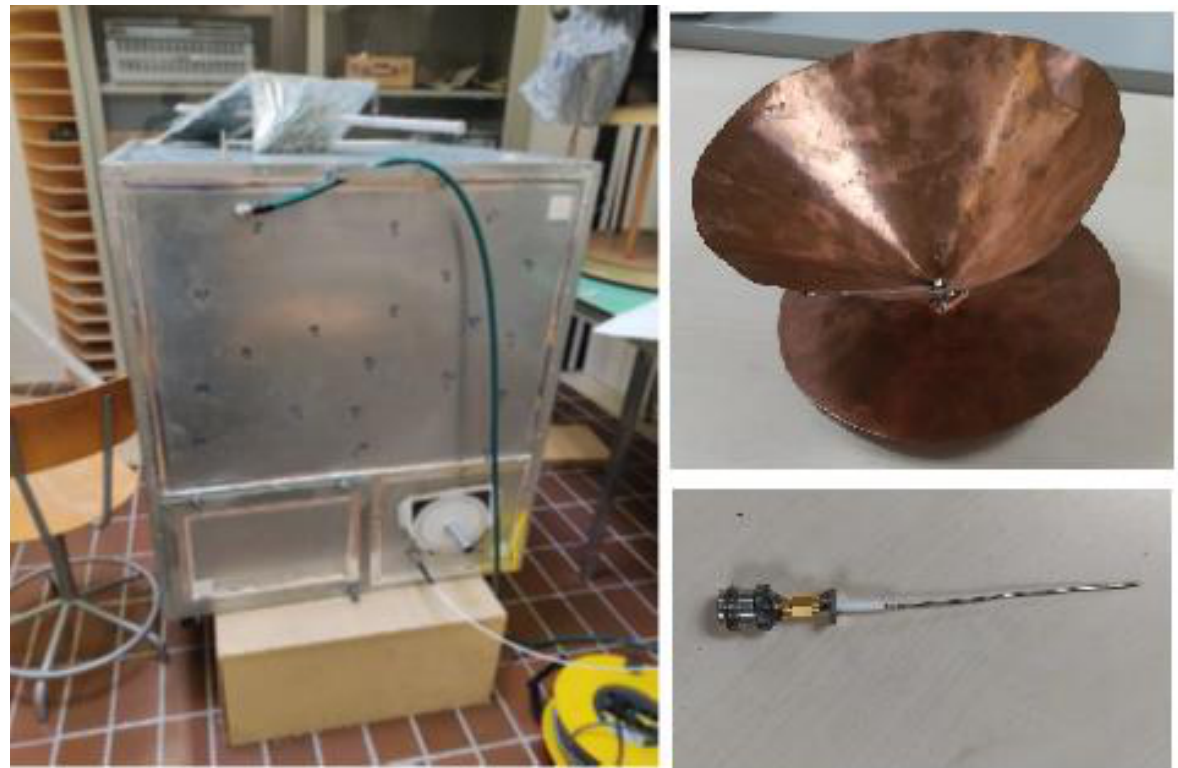
Figure 6. Experimental Setup: on the left, the reverberation chamber, and on the right, the discone and monopole antennas.